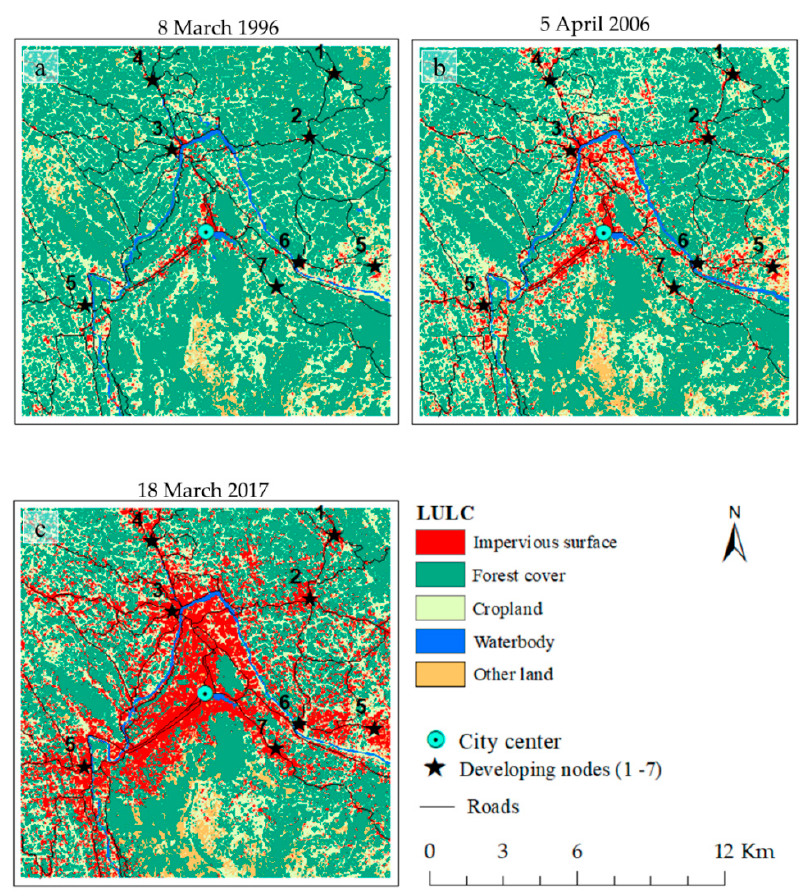
Figure 4. LULC in ( a ) 1996, ( b ) 2006, and ( c ) 2017. Note: Developing nodes 1–7 are Wattegama,